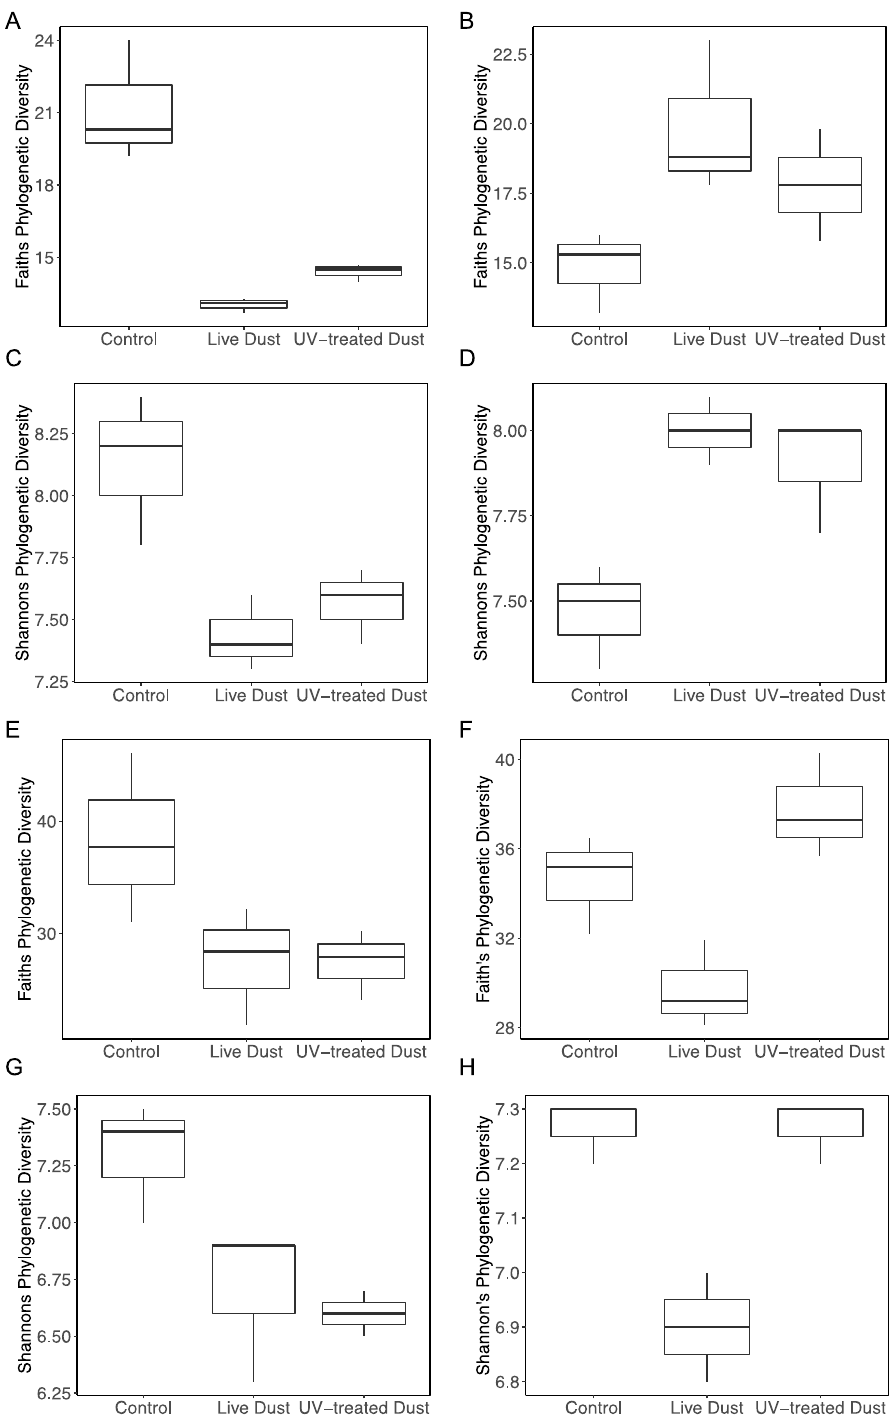
Figure 6. Diversity indices of prokaryotes, ( A ) Shannon’s diversity indices at 20 h ( B ) Faith’s phylogenetic diversity indices at 20 h, ( C ) Shannon’s diversity indices at 44 h ( D ) Faith’s phylogenetic diversity indices at 44 h, and diversity indices of eukaryotes, ( E ) Shannon’s diversity indices at 20 h ( F ) Faith’s phylogenetic diversity indices at 20 h, ( G ) Shannon’s diversity indices at 44 h ( H ) Faith’s phylogenetic diversity indices at 44 h, for control, live dust, and UV-treated dust treatments. The ends of the box are the upper and lower quartiles, so the box spans the interquartile range. The median for each treatment of three replicates is marked by a horizontal line inside the box. The whiskers are the two lines outside the box that extend to the highest and lowest observations.